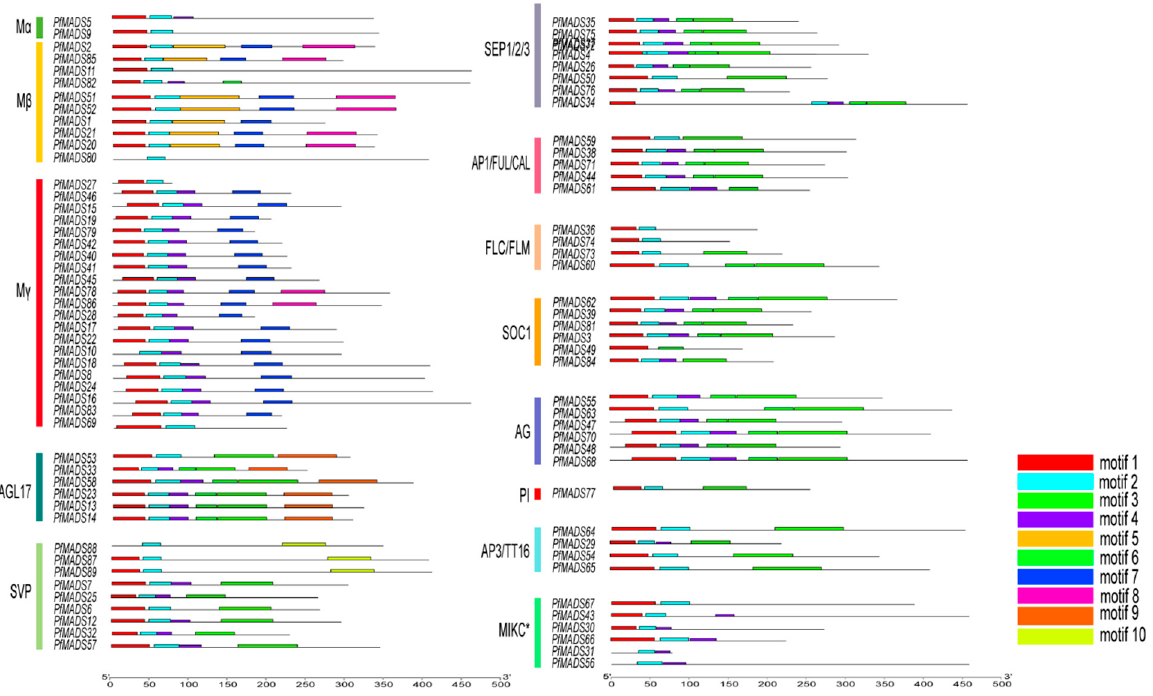
Figure 4. The motif composition of PfMADS-box genes. Ten motifs are labeled by different colors.